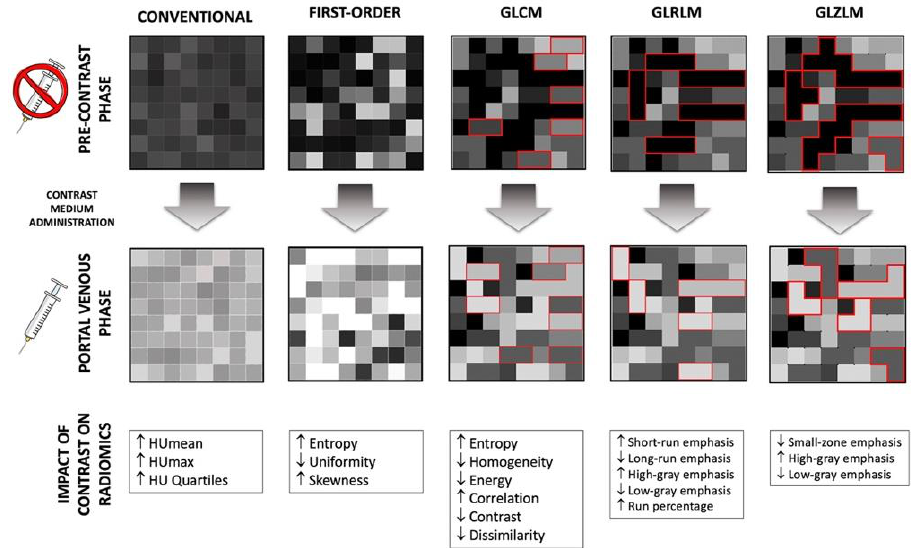
Figure 2. Effect of contrast medium on textural features in the Tumor-VOI. The modification of first-order and second-order features after contrast medium administration is detailed in white boxes. HU: Hounsfield Units; GLCM: Gray-level co-localization matrices; GLRLM: Gray-level run length matrices; GLZLM: Gray-level zone length matrices.